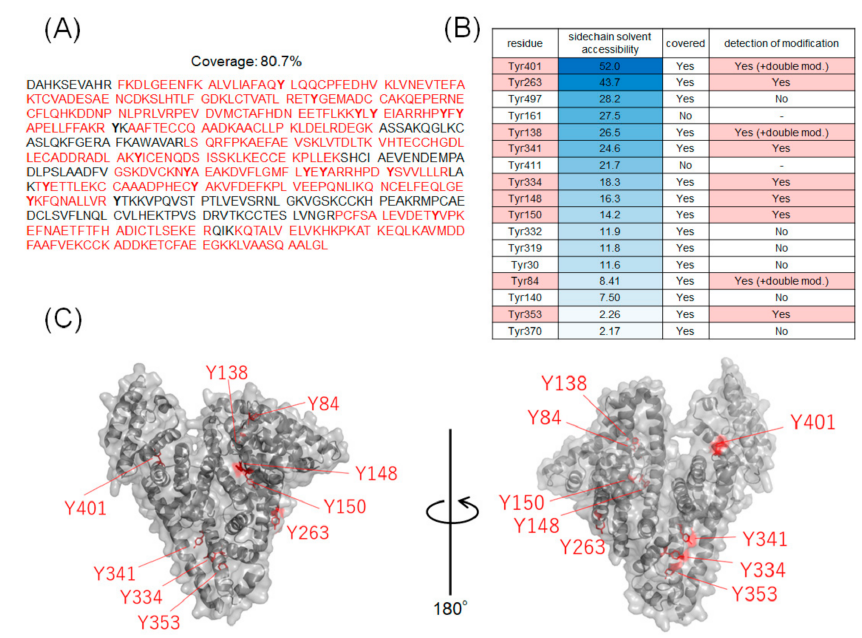
Figure 2. Tyrosine residues in modified HSA. ( A ) Amino acid sequences of HSA and peptide fragments detected by nanoLC-MS/MS analysis. ( B ) Sidechain solvent accessibility of tyrosine residues and labeling sites. The peptide fragment containing Tyr161 and Tyr411 were not detected. ( C ) Mapping of modified tyrosine residues on 3D structures